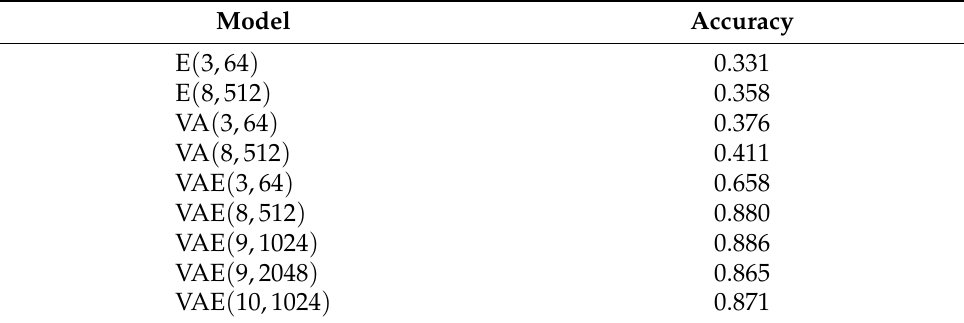
Table 5. The accuracy of the SFER model on test